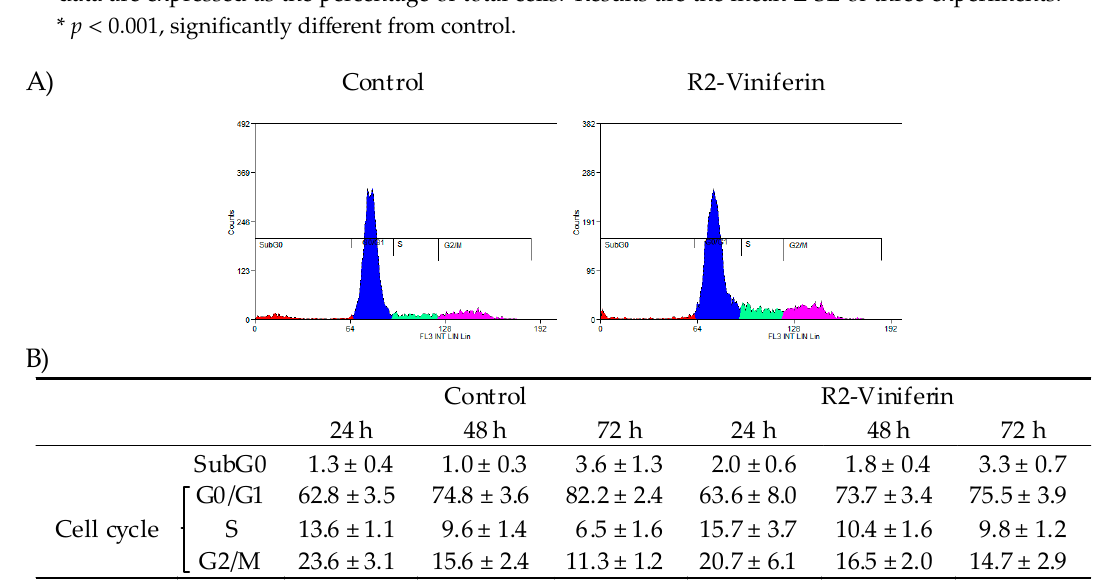
Figure 4. Cell cycle distribution of Hep3B treated with R2-viniferin. ( A ) Representative graphs of cell cycle analysis by flow cytometry at 72 h. ( B ) Statistical analysis of cell cycle distribution. Data are expressed as the percentage (%) of cells at different stages of cell cycle. In the case of cells in subG0, data are expressed as the percentage of total cells. Results are the mean ± SE of three experiments.